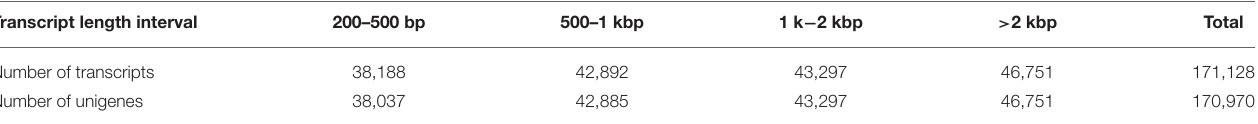
TABLE 2 | Transcript length distribution.